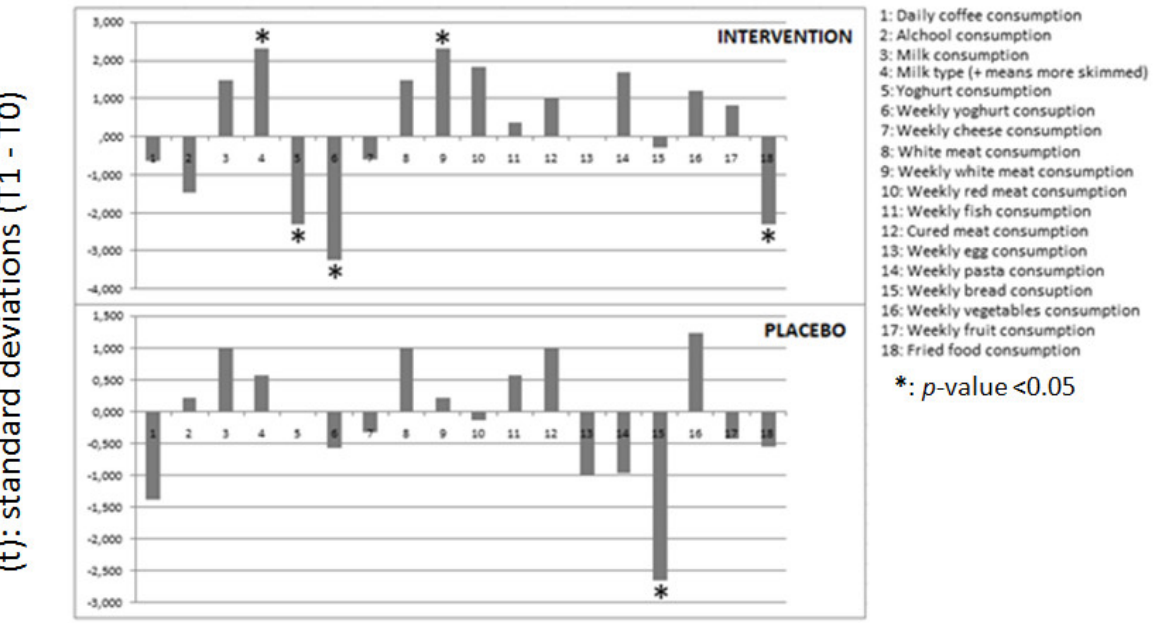
Figure 2. Food Frequency Questionnaire (FFQ) changes between T1 and T0.